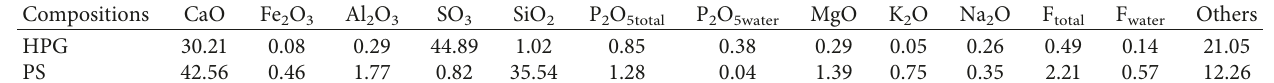
Table 1: Main chemical compositions of HPG and PS (wt.%).